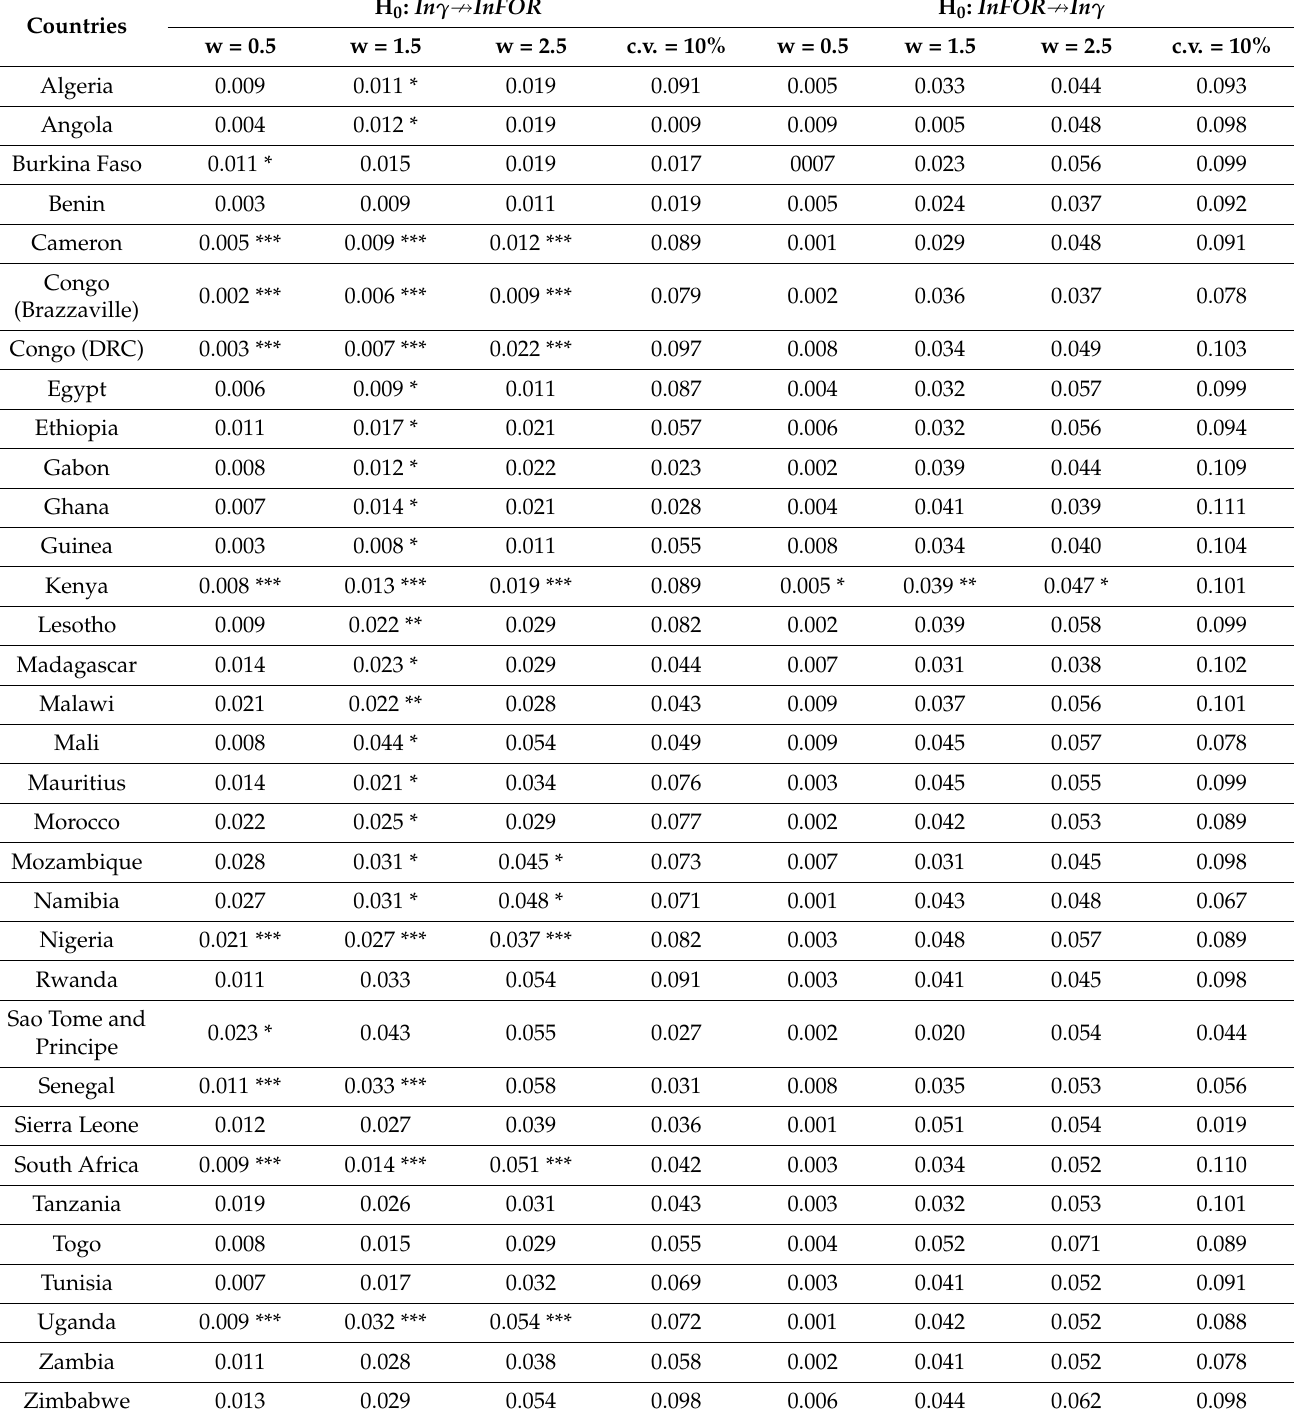
Table 8. Granger causality tests in the frequency domain estimates In γ , InFOR